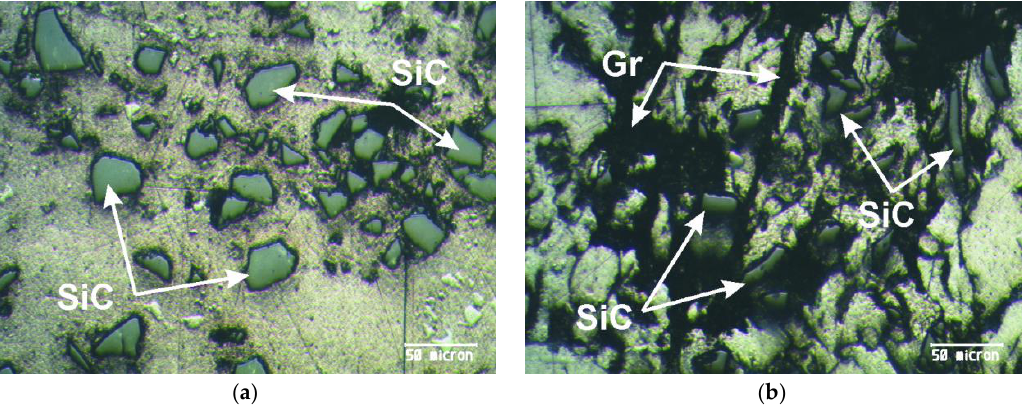
Figure 1. The microstructure of the tested composites: ( a ) ZA27/5%SiC; ( b ) ZA27/5% SiC/5%Gr.